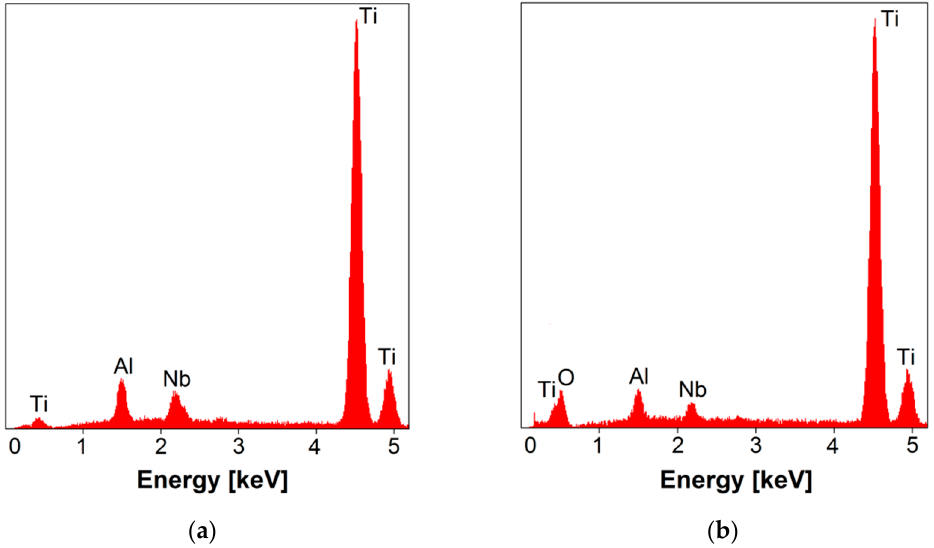
Figure 3. Energy dispersive spectrum in the Ti ‐ 6Al ‐ 7Nb alloy surface’s micro ‐ region: ( a ) before isothermal oxidation; ( b ) after isothermal oxidation at 800 °C.